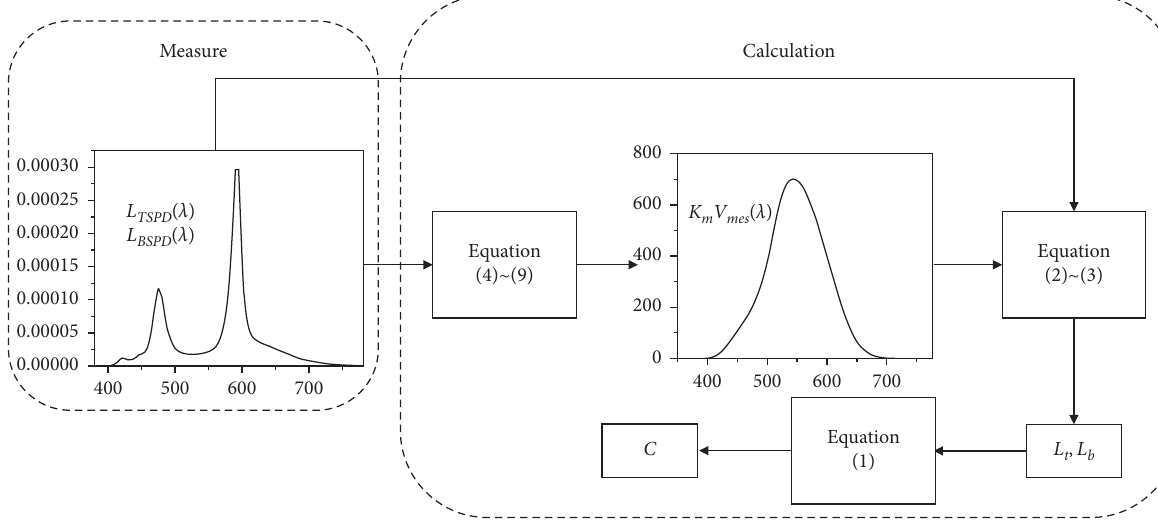
Figure 6: The calculation process of C